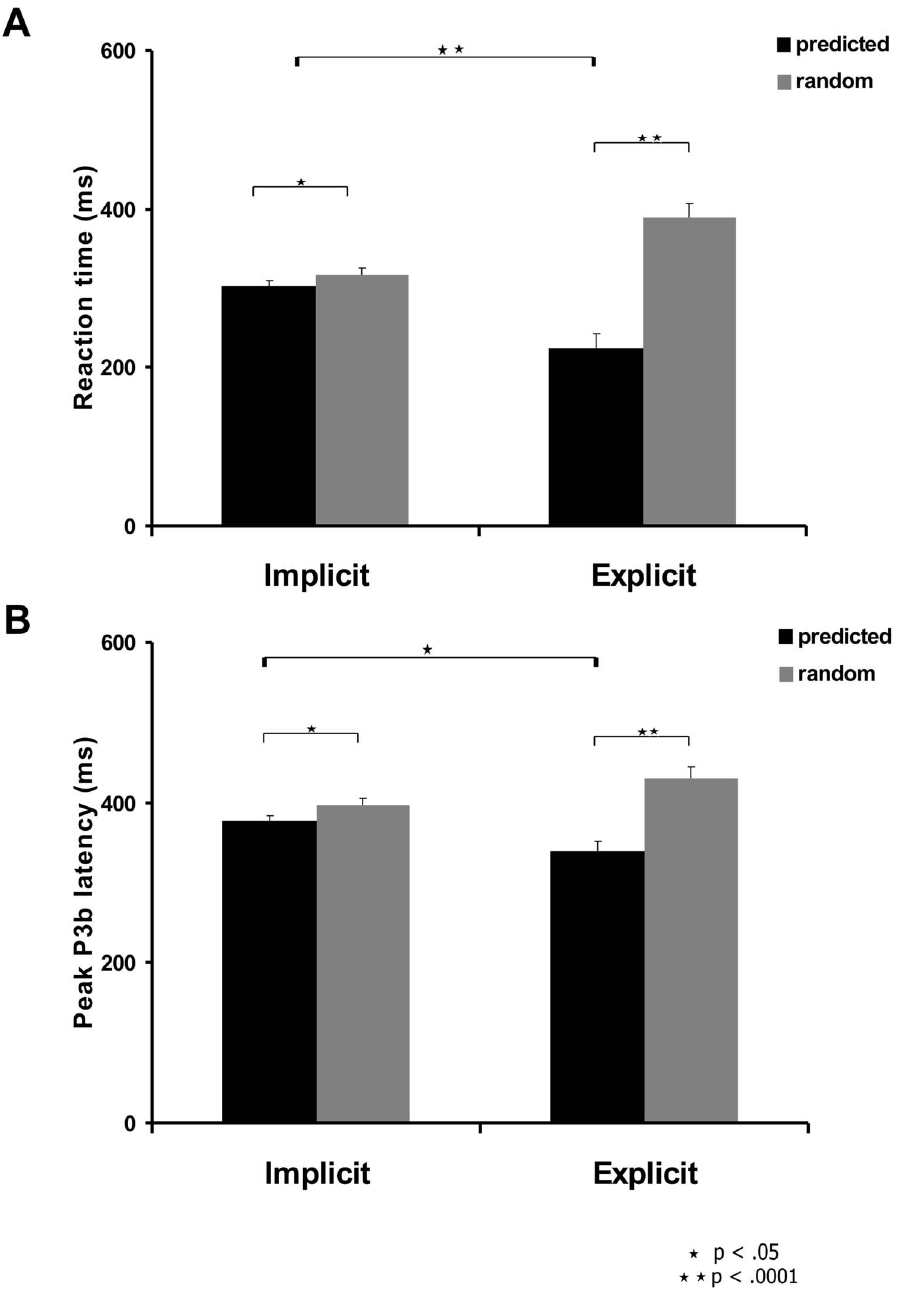
Figure 2. Reaction times (A) and P3b peak latency at CPz (B) for predicted and random targets in the implicit and explicit sessions. Bars=SEM.